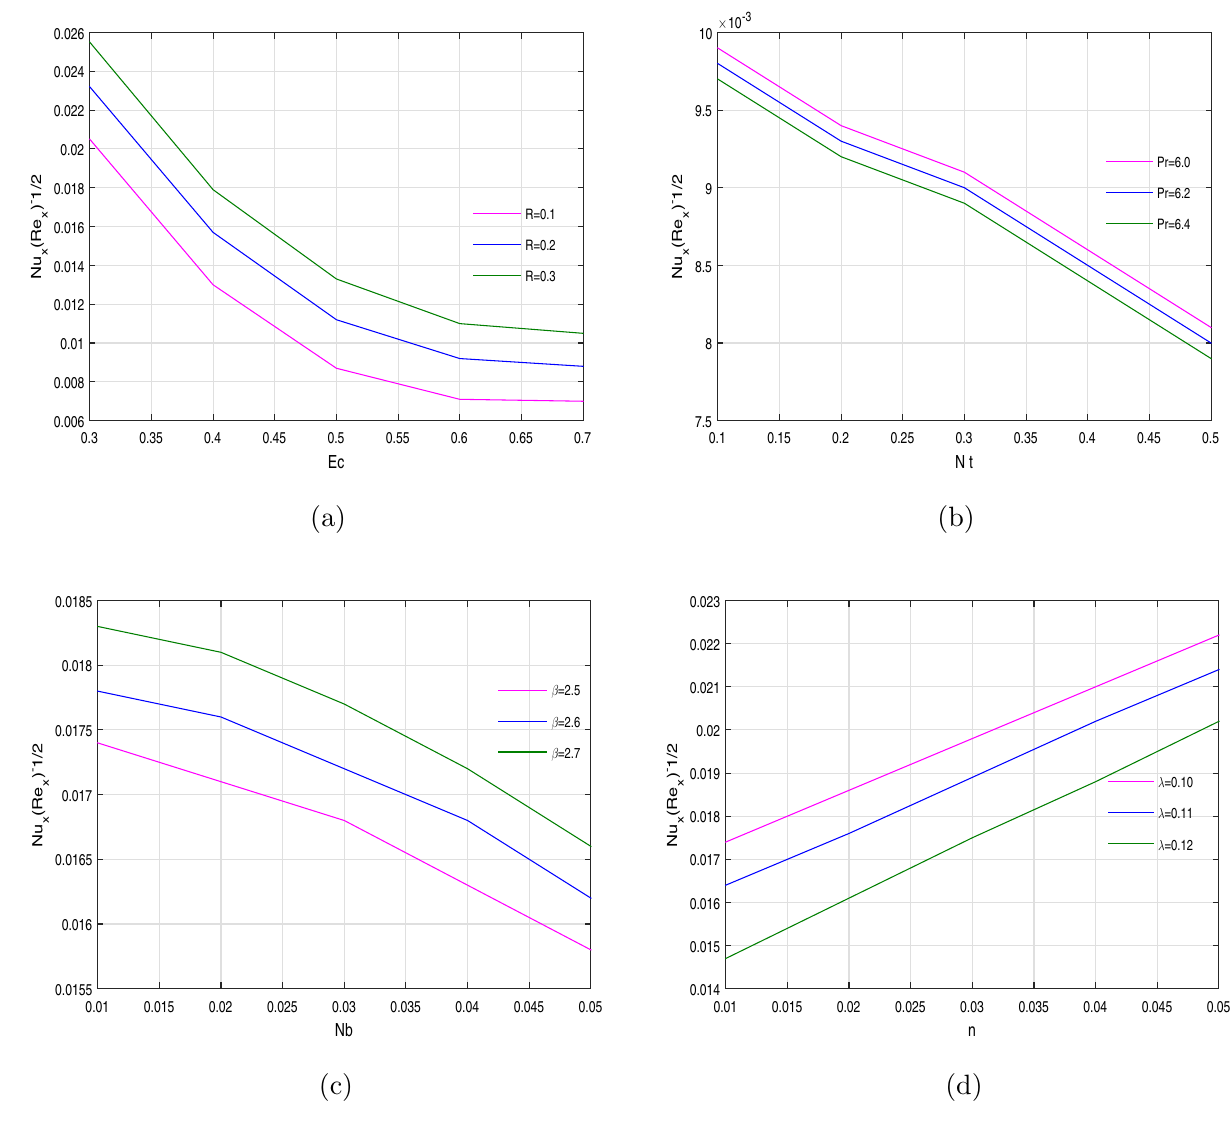
Figure 10. Variation of Nusselt number against different physical